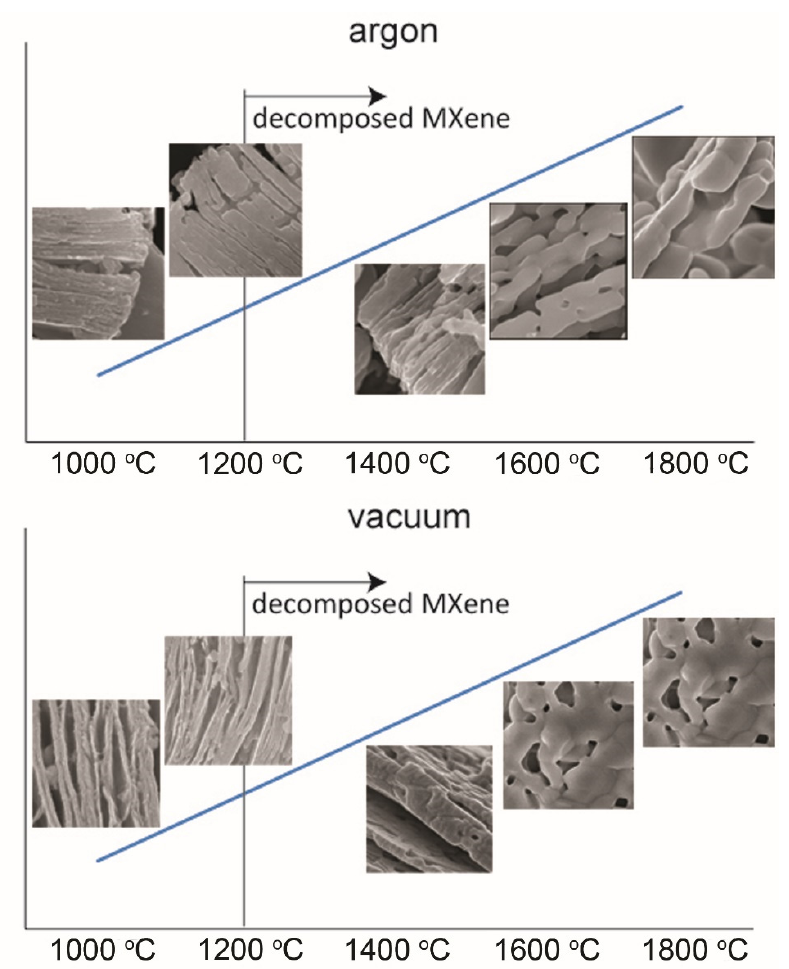
Figure 3. Diagram showing the decomposition steps of MXene annealed in argon and vacuum.